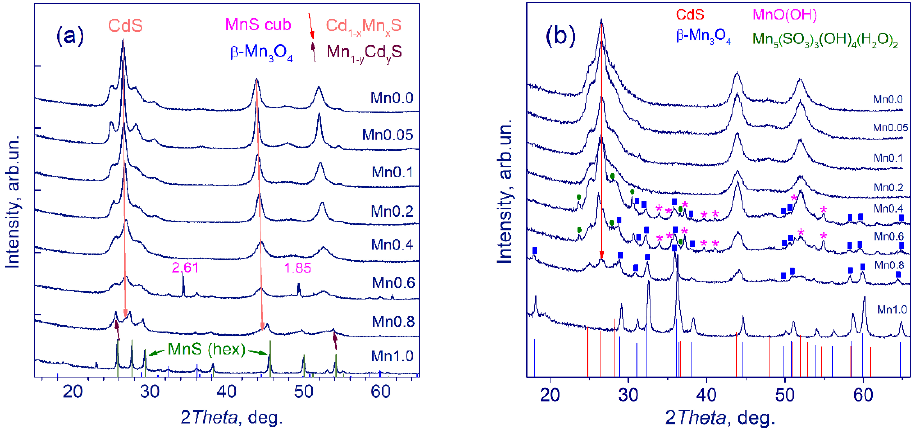
Figure 1. X-ray diffraction (XRD) patterns of the samples Mnx (x = 0–1.0) ( a ) and Mnx(NaOH) (x = 0–1.0) ( b ). The obtained Mnx series samples had a highly defective cubic structure with a low particle size. According to the XRD patterns, the best method for the formation of solid solutions is the use of the direct deposition of cadmium and manganese sulfides according to Equation (3) with further hydrothermal treatment. In this case, we observed not only a sequential shift of the sample diffraction peaks towards larger 2 Θ angles but also a gradual decrease in the lattice constant with an increase in the molar fraction of Mn (Table 1). This trend is consistent with Vegard’s law and indicates a homogeneous structure. The highest manganese content, 35 at%, was achieved for the photocatalyst Mn0.4 : a single-phase solid solution Cd 0.65 Mn 0.35 S was formed. Notably, earlier with the use of sodium sulfite as the sulfur precursor, the atomic ratio of manganese did not exceed 5% [24]. For the sam- ples Mn0.6 and Mn0.8 , two-phase Cd 0.65 Mn 0.35 S/MnS and Cd 0.65 Mn 0.35 S/Mn 0.92 Cd 0.08 S structures were formed. Note that the Cd 1 − x Mn x S crystalline size sharply grew from 7.1 to 13 nm when moving from CdS to Cd 0.95 Mn 0.05 S and then fell monotonously from 13 to 4.3 nm when Mn at% grew from 0.05 to 0.8. The XRD pattern of the Mn1.0 sample possesses a hexagonal well crystallized MnS structure with a particle size of approximately 37 nm; impurities of β -Mn 3 O 4 were also observed in XRD pattern of the sample Mn1.0 . Also, very insignificant amounts of β -Mn 3 O 4 were identified in the XRD patterns of the samples Mn0.6 and Mn0.8